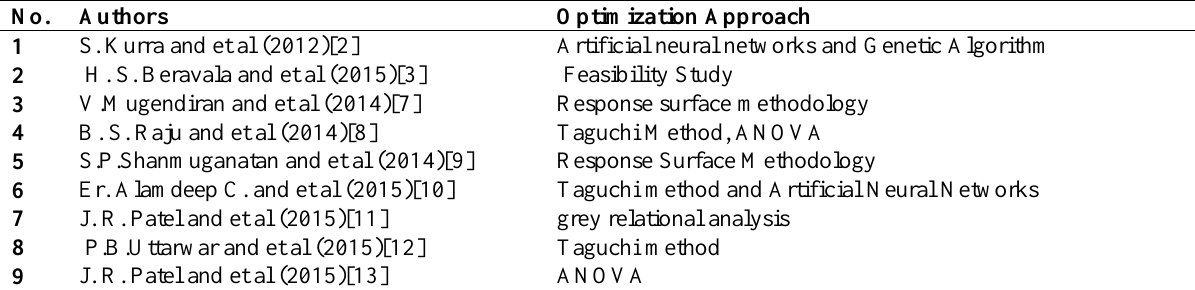
Literature review presents the optimization approach in SPIF